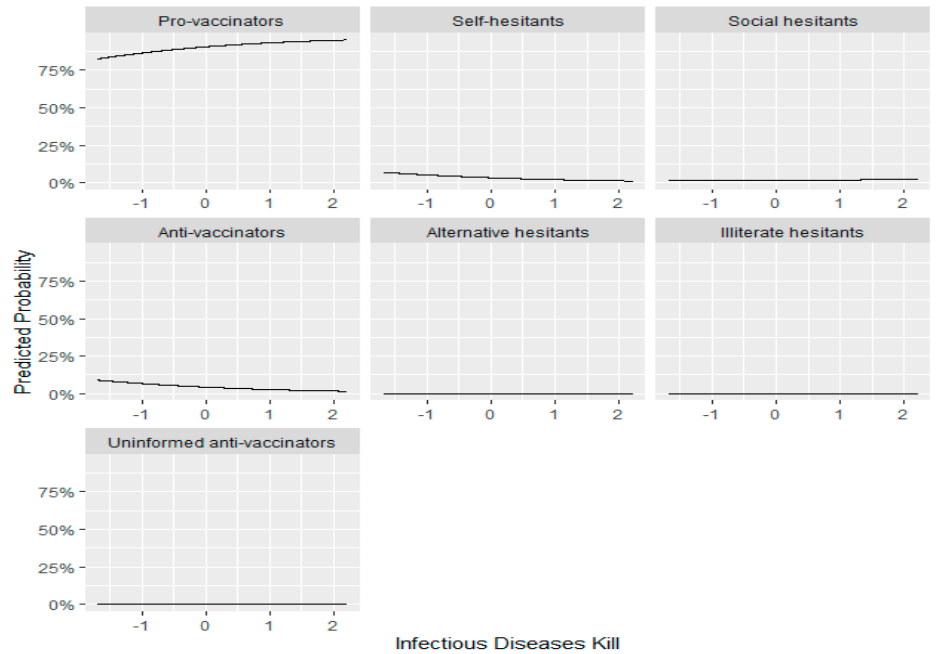
Figure A2. Marginal Effects Multinomial Logistic Regression. Infectious Diseases Kill.